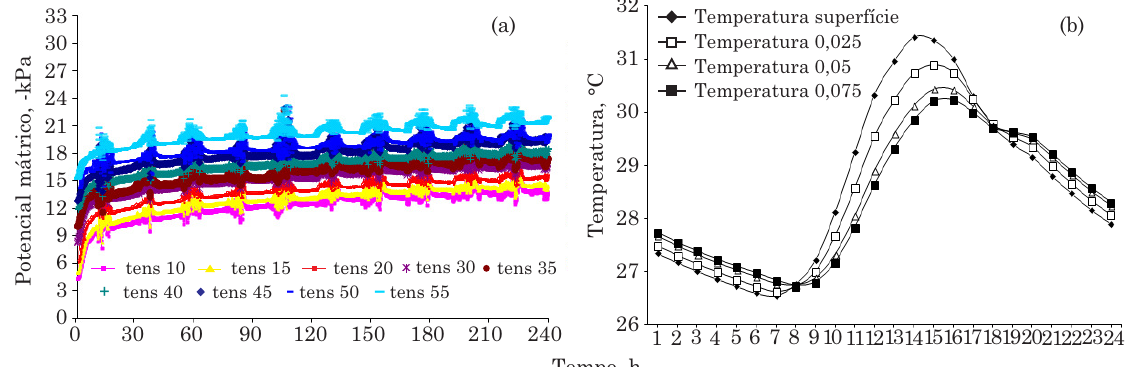
Figura 1. Potencial mátrico da água no solo (a) e temperatura média por período (b), durante os 10 dias de